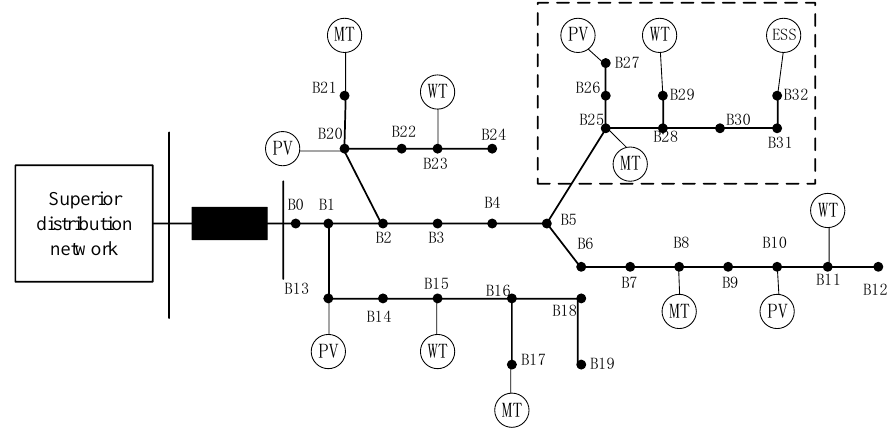
Figure 1. IEEE33 node power distribution system.